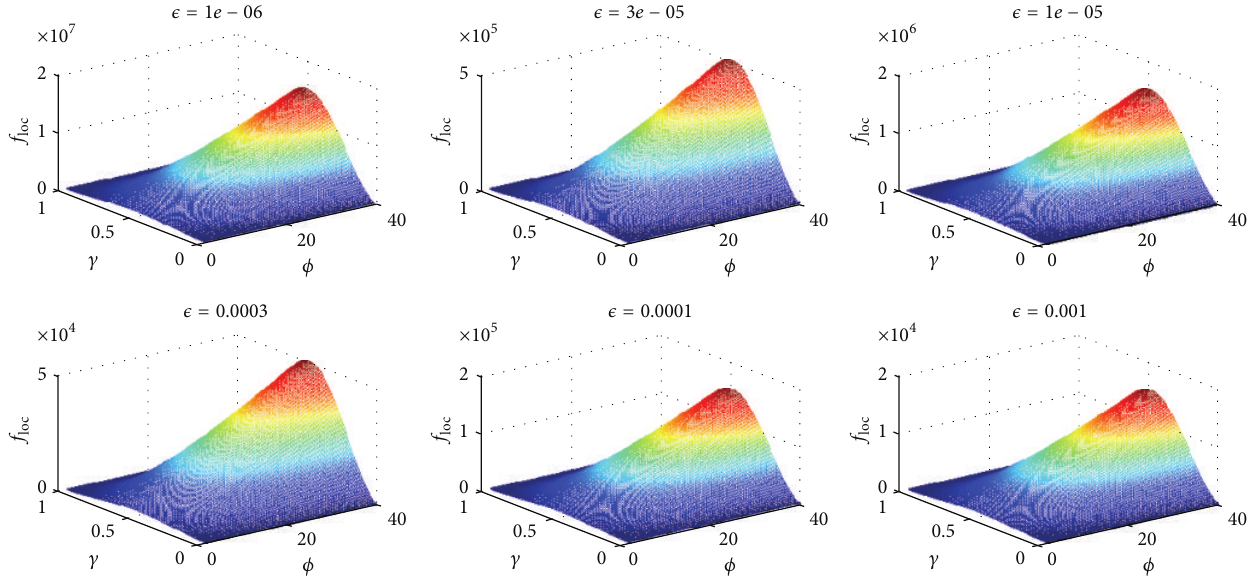
Figure 1: Local free energy density with respect to different 𝜖